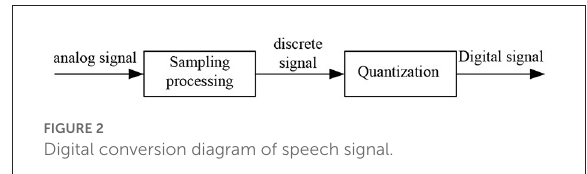
FIGURE2 Digital conversion diagram of speech signal.